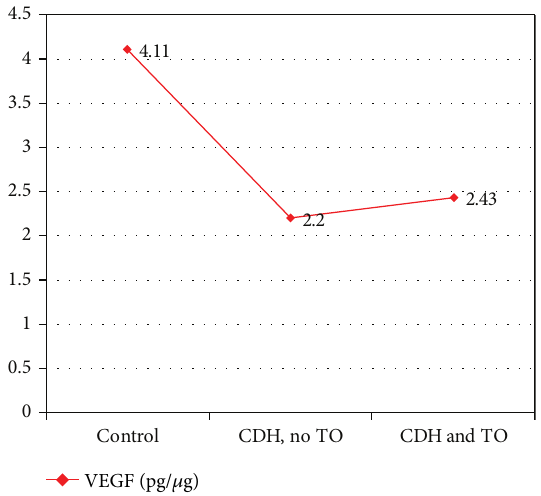
Figure 8: VEGF values in control rats, fetuses with congenital diaphragmatichernia(CDH),andfetuseswithCDHthatunderwent tracheal occlusion